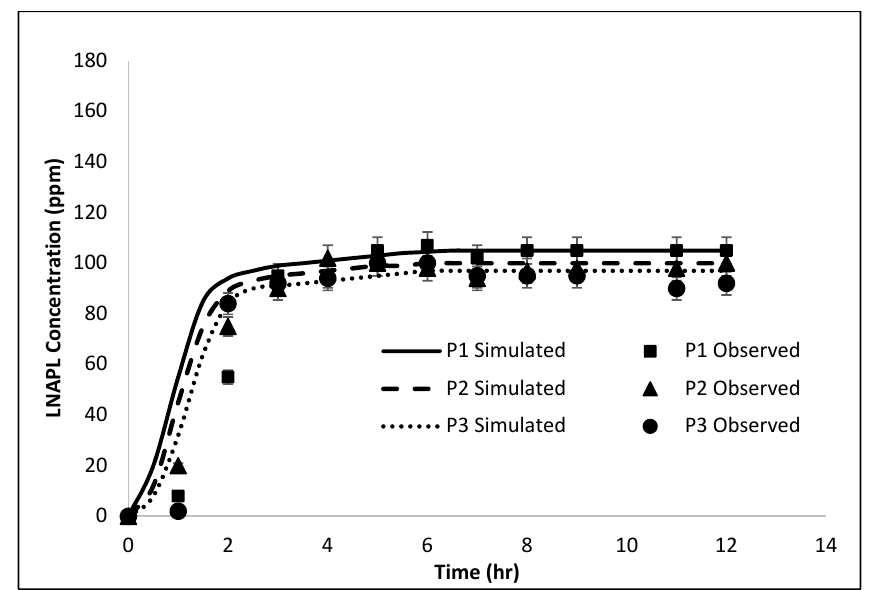
Figure 4. Concentration of NAPL at sampling ports P1, P2, and P3 of column setup at soil-water temperature of 20 ◦